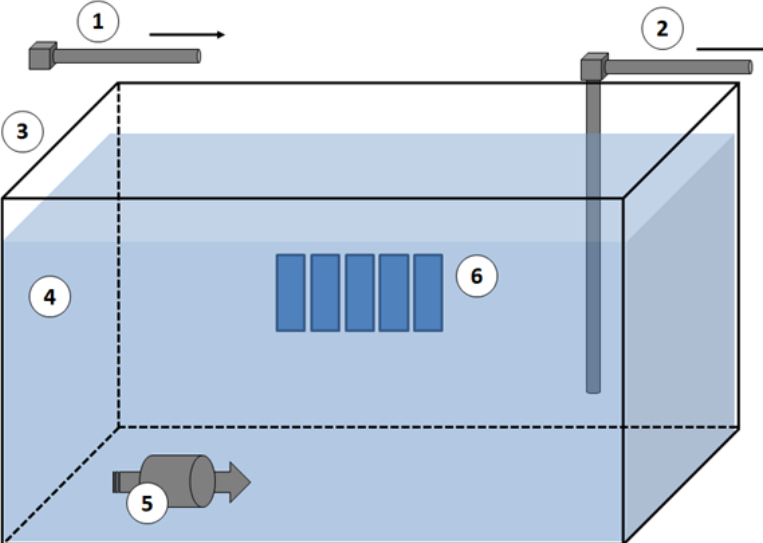
) inlet seawater ➀